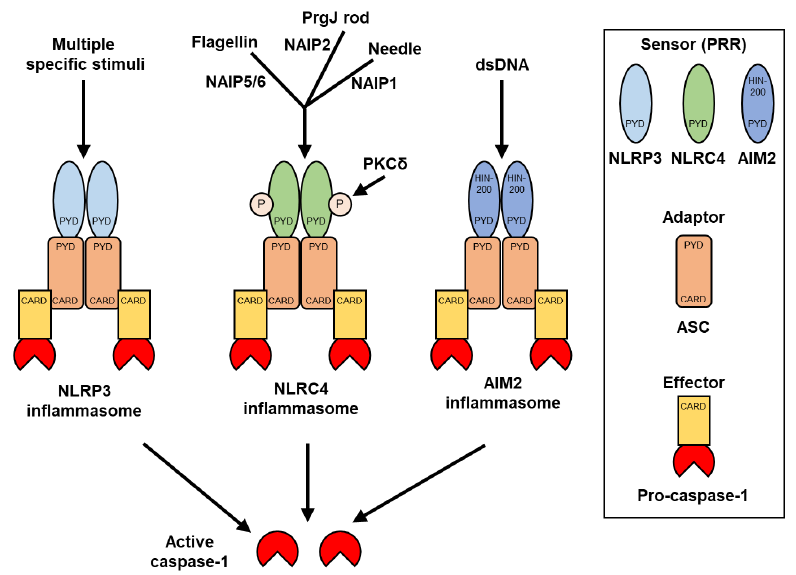
Figure 1. Components of NLRP3, NLRC4, and AIM2 inflammasomes. NLRP3, NLRC4, and AIM2 sense specific stimuli and induce assembly of inflammasomes with ASC and pro-caspase-1. Although NLRP3 reacts with multiple specific stimuli, NLRC4 reacts with cytosolic flagellin, PrgJ rod protein, and needle protein through NLR family, apoptosis inhibitory proteins (NAIPs), whereas AIM2 reacts with cytosolic dsDNA. The activated pattern recognition receptors (PRRs) interact with ASC via its pyrin domain (PYD). ASC interacts with caspase-1 via its caspase recruitment domain (CARD). Inflammasomes induce caspase-1 activation, which leads to both IL-1 β and IL-18 maturation as well as cell death (pyroptosis). P indicates phosphorylation of NLRC4 by PKC δ